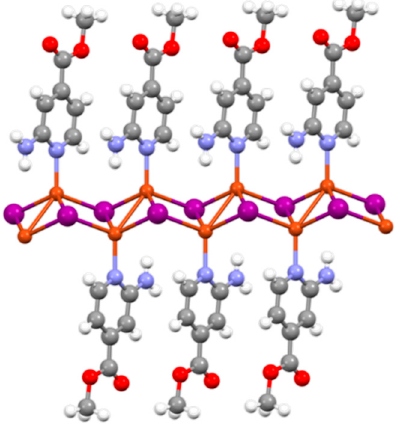
Figure 1. Example of a one-dimensional coordination polymer based on a copper(I)-iodide double chain. The represented coordination polymer (CP) is [CuI(NH 2 -MeIN) 2 ] n (NH 2 -MeIN = methyl 2-aminoisonicotinate) [22]. Grey: C; white: H; blue: N; red: O; orange: Cu; purple: I.